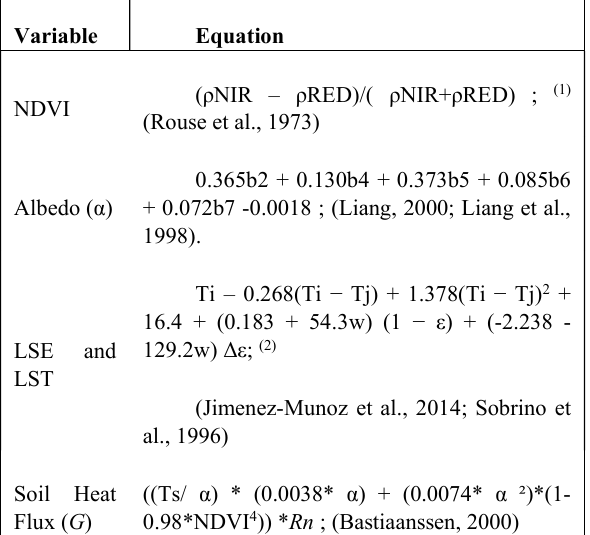
Table 2. Equations used to the pre-processing image